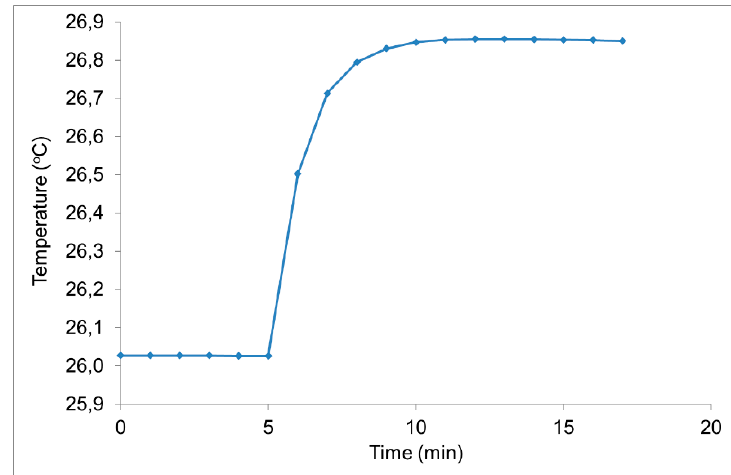
Figure 2. Temperature profile vs. time during the measurement of a typical sample’s higher heating value of combustion.